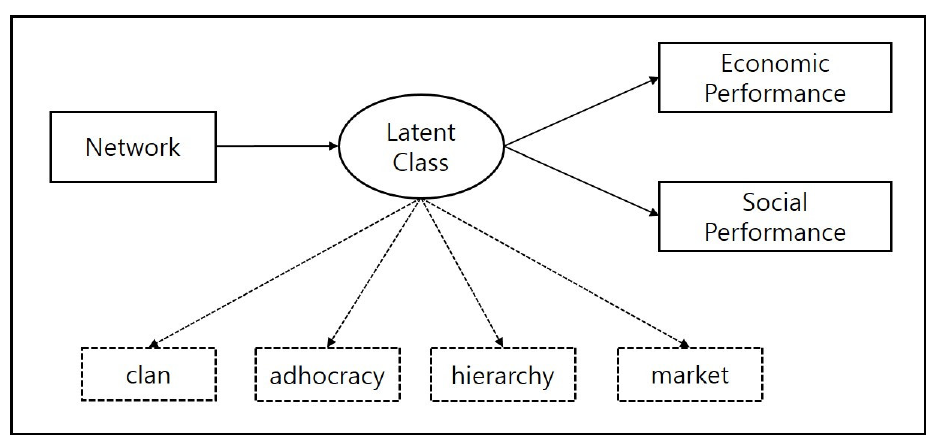
Figure 2. Path diagram of the model, specifying the relationship between latent class (profile) and external variables.